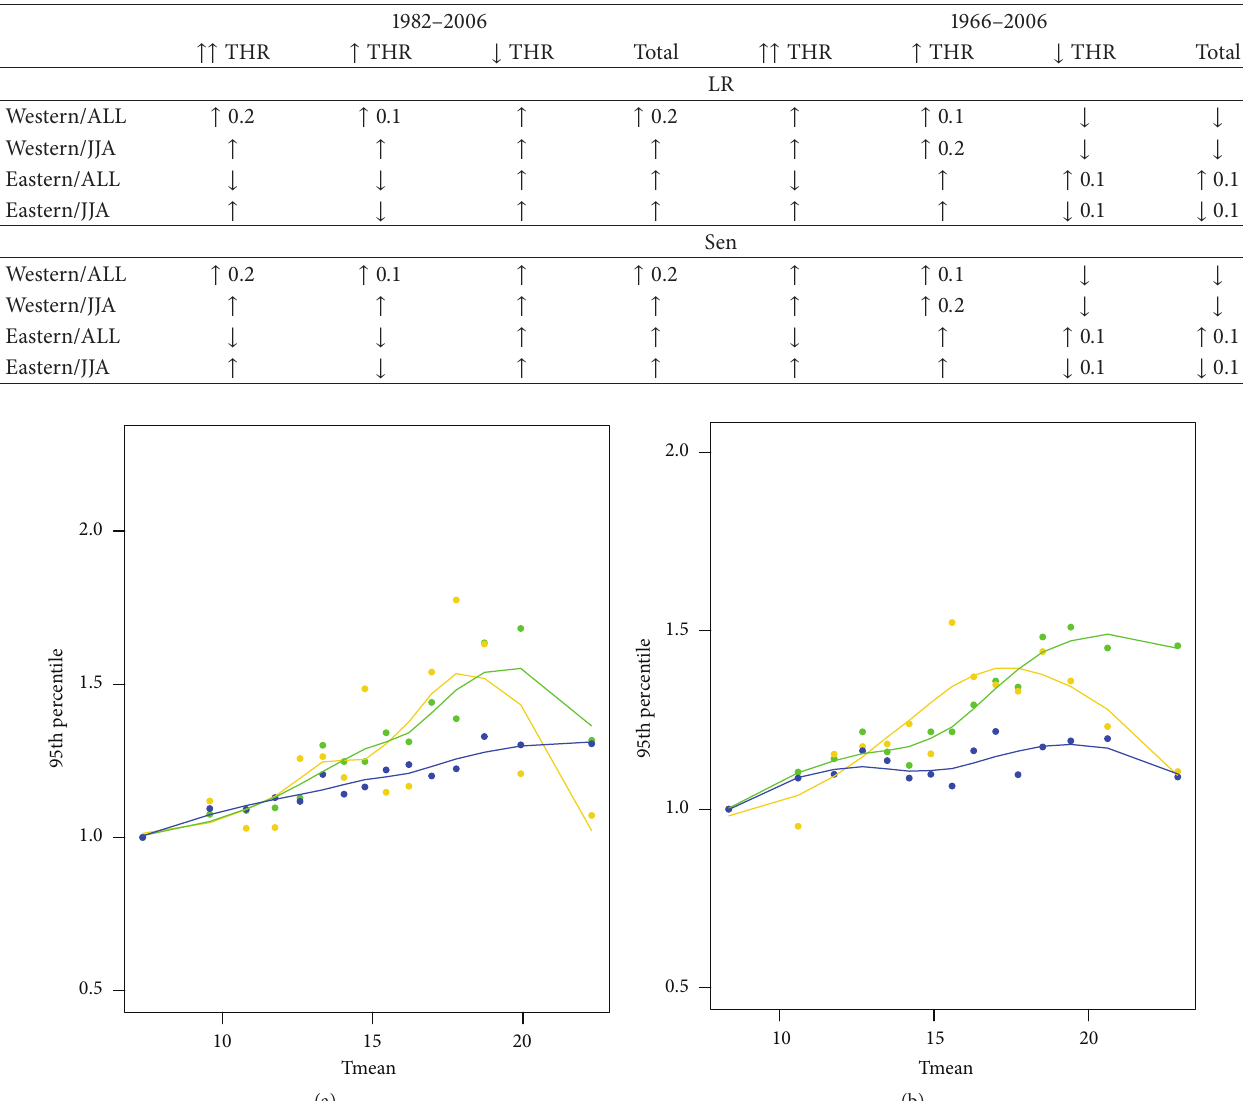
Table 5: Precipitation amounts above and below THR 1982–2006 and 1966–2006 for both regions and ALL and JJA data. 0.1 (0.2) denotes trend significant at 0.1 (0.2) level.